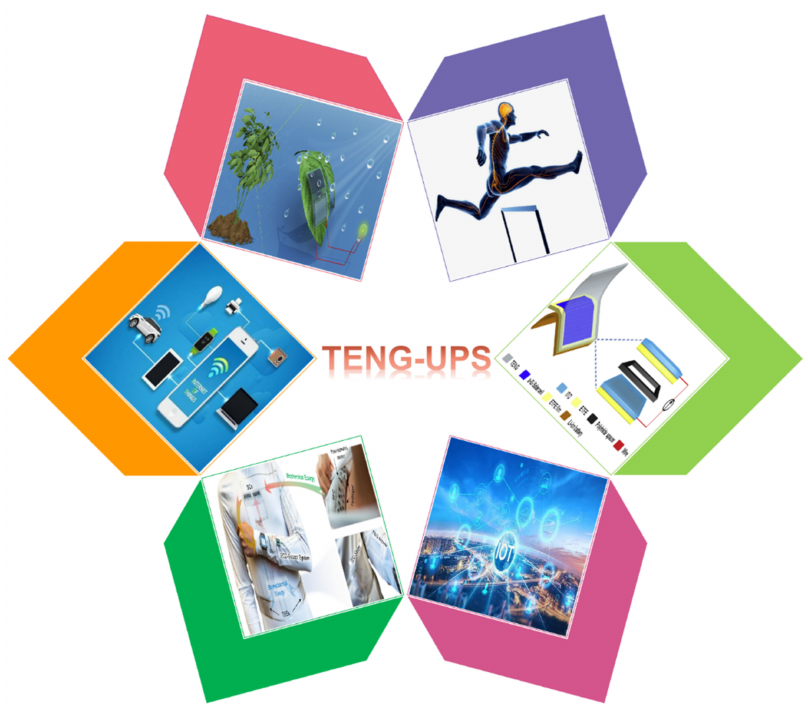
Figure 1. TENG-based uninterrupted power supply